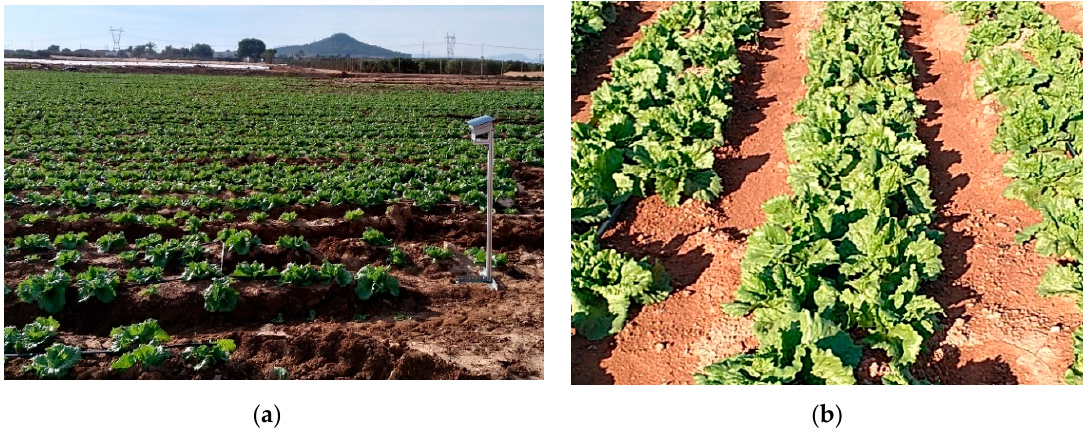
Figure 9. Global view of a remote capture node in the field. ( a ) Location of the node on a crop of lettuce. ( b ) Sample image captured by the system.